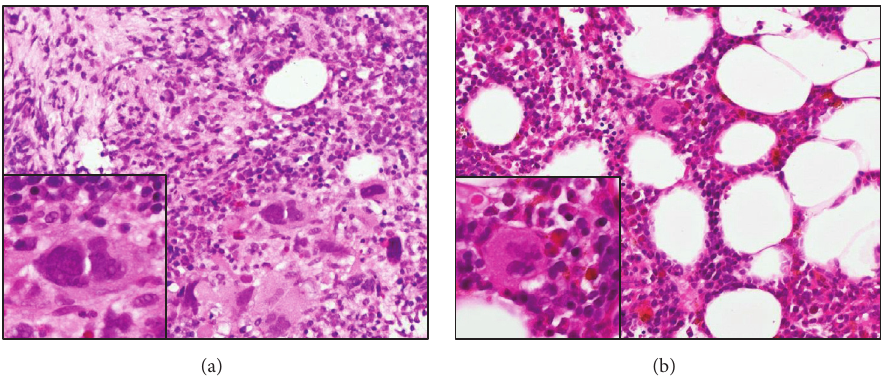
Figure 2: Case 1. Histology of bone marrow (HE stain). (a) Before HCT, the bone marrow biopsy showed severe fibrosis (MF-2), and the megakaryocytes had changed morphologically. (b) After HCT, the marrow specimen showed that the fibrosis regressed (MF-0), and the morphological abnormalities in megakaryocytes had